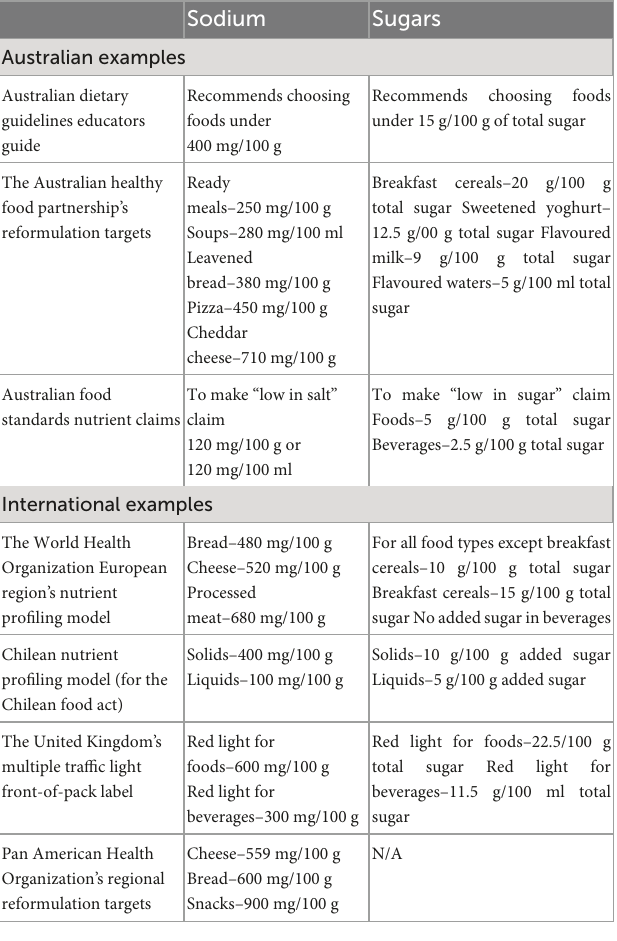
TABLE 2 Sodium and free sugar thresholds for the developed model. Sodium Free